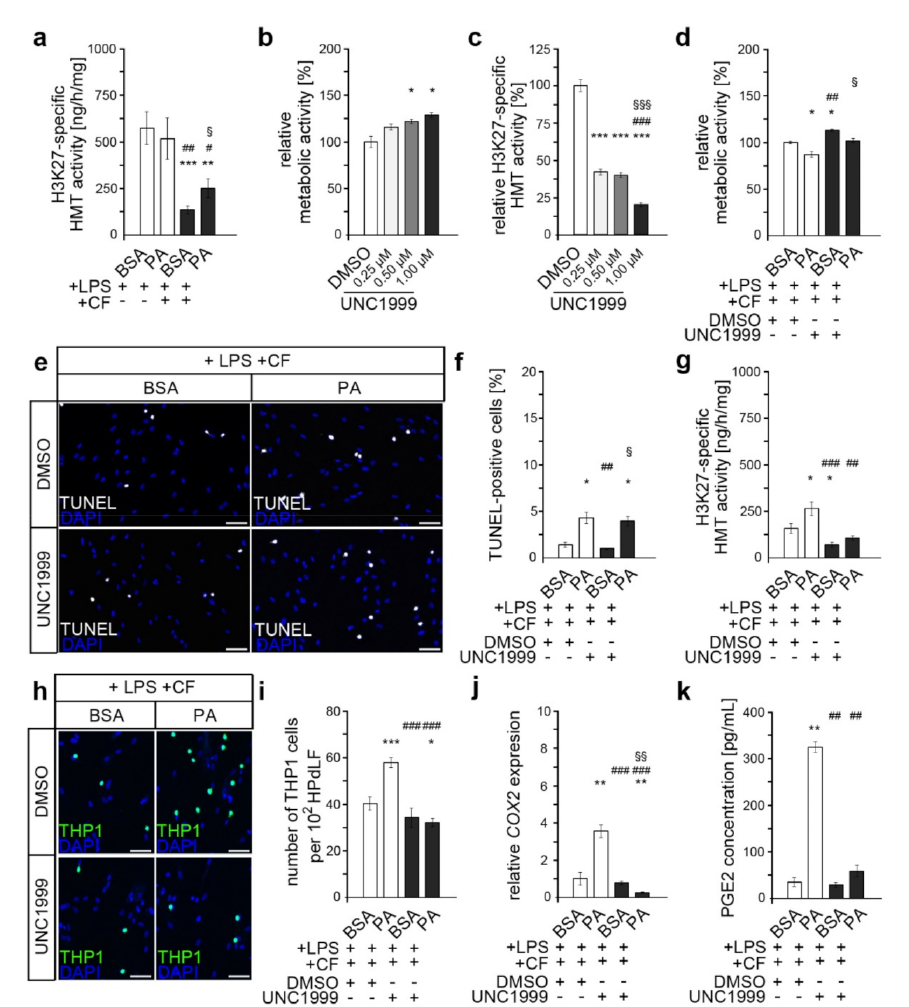
Figure 3. Inhibition of H3K27 trimethylation abrogates the PA-induced excessive inflammatory response of dual-stimulated HPdLFs. ( a ) Analysis of the activity of histone methyltransferases (HMTs) specifically methylating H3K27 in HPdLFs treated with palmitic acid (PA) for six days prior to treatment with P. gingivalis LPS and compressive force (CF) for six hours. ( b ) Metabolic activity analyzed in HPdLFs treated with different concentrations of UNC1999 for six hours normalized to DMSO control. ( c ) Analysis of H3K27-specific HMT activity in HPdLFs treated with 1.00 µ M UNC1999 in relation to DMSO control. ( d ) Metabolic activity in dual-stressed HPdLFs treated with 1.00 µ M UNC1999 in relation to DMSO-treated BSA+LPS+CF control. ( e ) Representative images of TUNEL-positive dual-stressed HPdLFs (white) treated with 1.00 µ M UNC1999, with ( f ) indicating the number of apoptotic cells analyzed. ( g ) H3K27-specific HMT activity measured in dual-stressed PA cultures treated with UNC1999. ( h ) Microphotographs of adherent THP1 monocytic cells (green) on compressed and P. gingivalis LPS-stimulated HPdLFs after treatment with 1.00 µ M UNC1999 in relation to DMSO-treated controls. Cell nuclei were labeled with DAPI (blue). The number of THP1 cells per 10 2 HPdLFs is displayed in ( i ). ( j , k ) Analysis of COX2 expression levels ( j ) and PGE2 secretion ( k ) in dual-stimulated PA cultures after treatment with 1.00 µ M UNC1999 in relation to DMSO-treated BSA+LPS+CF controls. */#/§ p < 0.05; **/##/§§ p < 0.01; ***/###/§§§ p < 0.001; */**/*** in relation to BSA+LPS ( a ), DMSO ( b , c ) and BSA+LPS+CF+DMSO ( d , f , g , i – k ); #/##/### in relation to PA+LPS ( a ), 0.25 µ M UNC1999 ( c ) and PA+LPS+CF+DMSO ( d , f , g , i – k ); §/§§/§§§ in relation to BSA+LPS+CF ( a ), 0.5 µ M UNC1999 ( c ) and BSA+LPS+CF+UNC1999 ( d , f , j ). One-way ANOVA and post hoc test (Tukey) were used for analysis. Scale bars: 10 µ m in ( h ) and 20 µ m in ( e